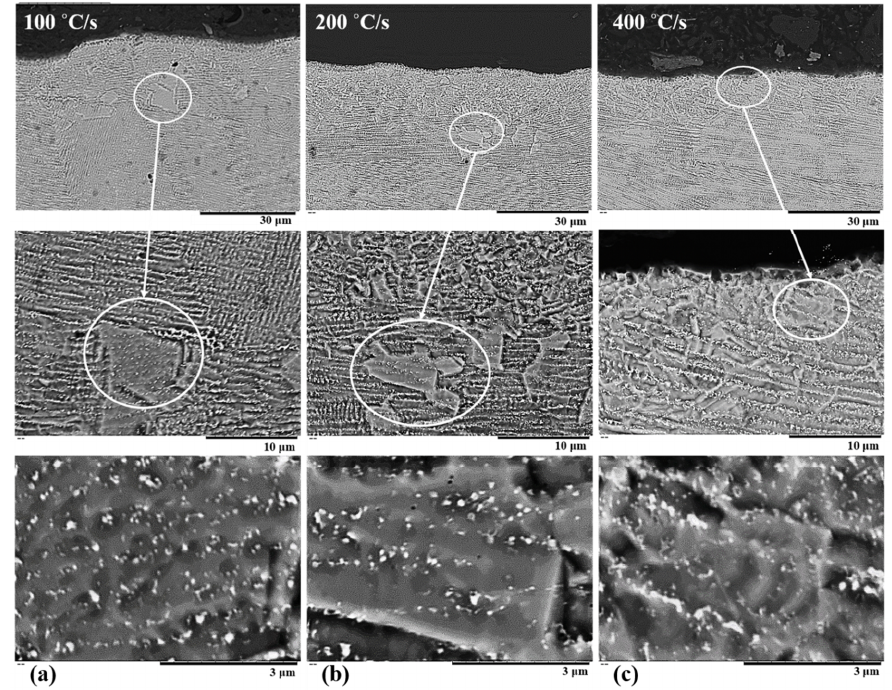
Figure 12. SEM images showing blocky zones in the sub-surface area at the mid-span of longitudinally cut samples heated to 1000 °C at the rates of ( a ) 100, ( b ) 200, ( c ) 400 °C/s and 10 s holding time, and cooled by constant rate 65 °C/s .